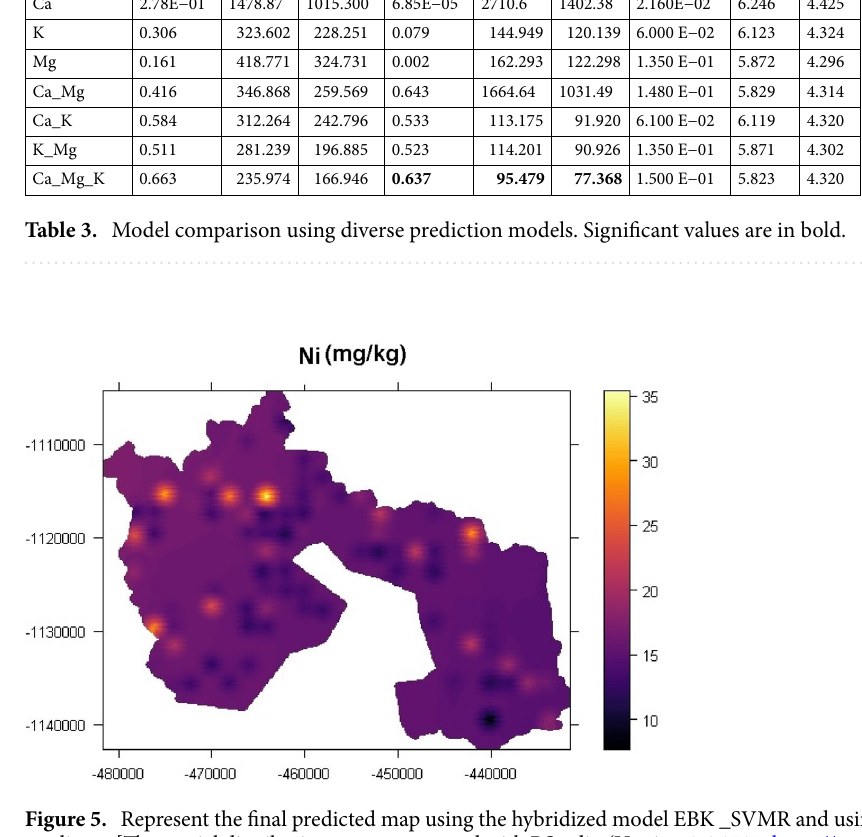
Figure 5. Represent the final predicted map using the hybridized model EBK _SVMR and using Ca_Mg_K as a predictor. [The spatial distribution map was created with RStudio (Version 1.4.1717: https:// www. rstud io.